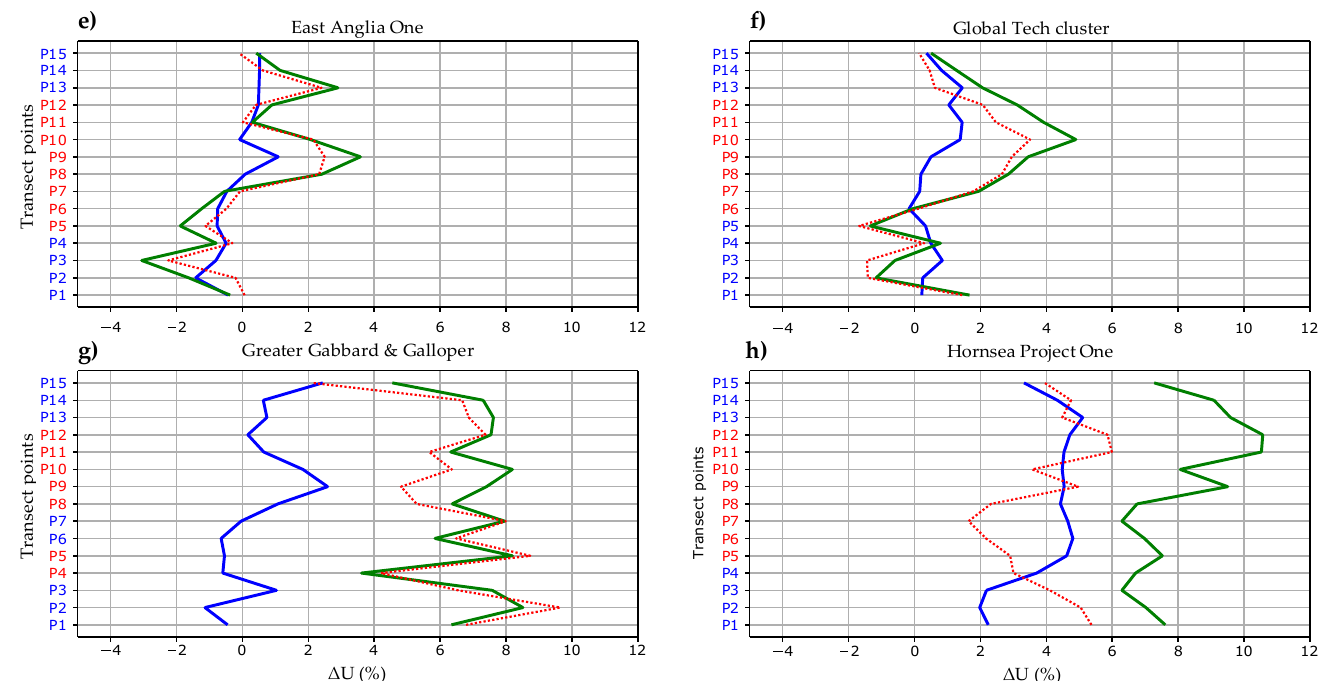
Velocity deficit before OWF Velocity deficit after OWC Green - Blue a) P15 P14 P13 P12 P11 P10 P9 P8 P7 P6 P5 P4 P3 P2 P1 c) P15 P14 P13 P12